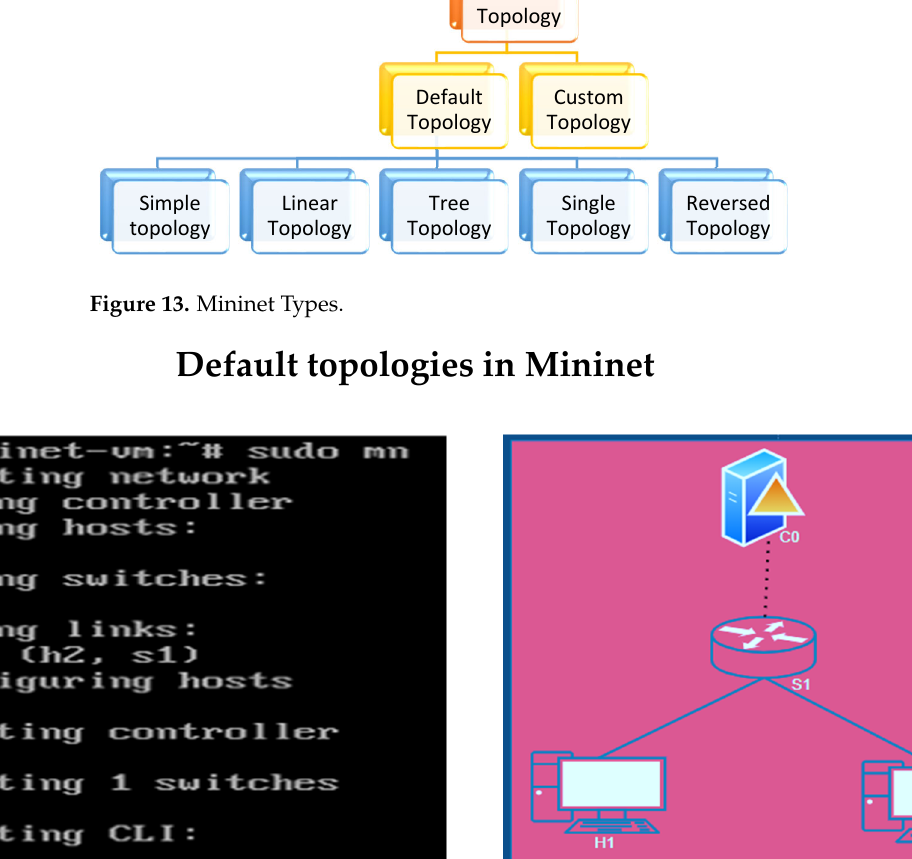
Figure 15. Single topology Mininet command: mn ‐‐ topo single,3.